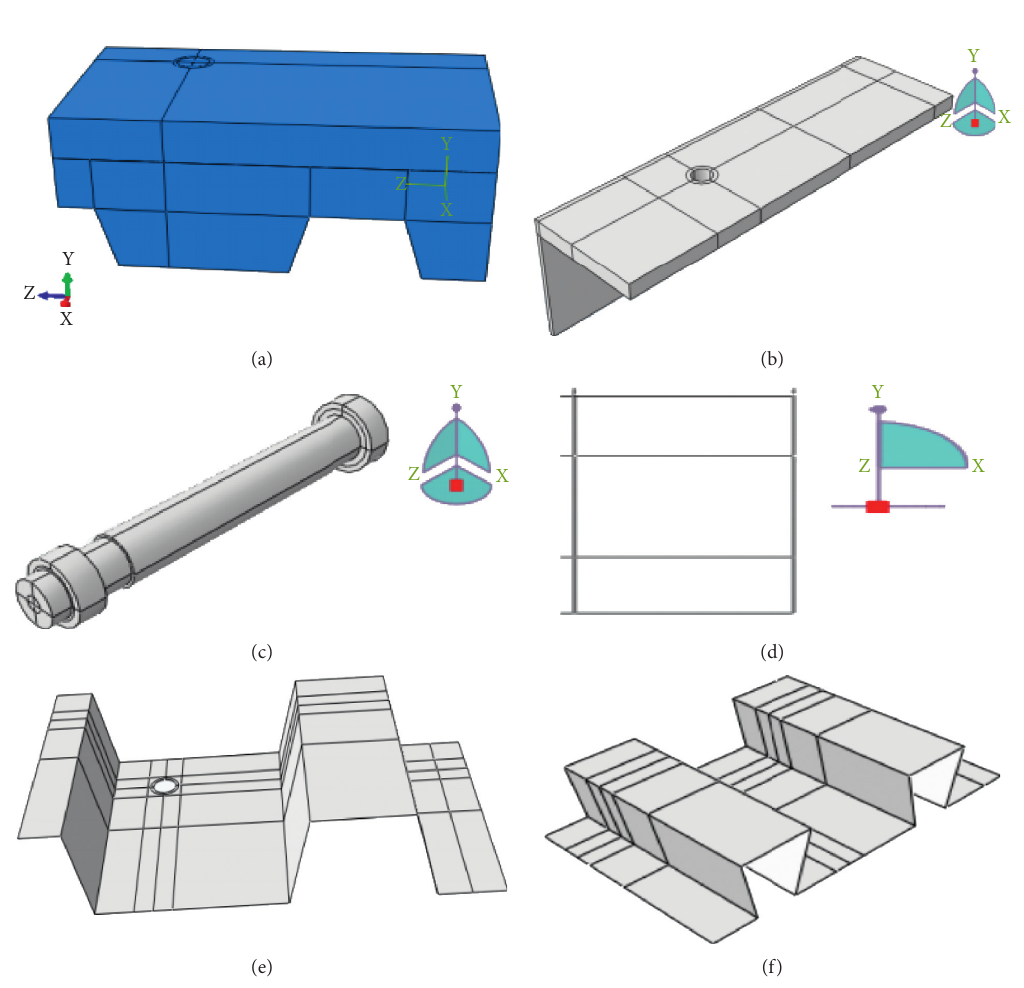
Figure 3: Parts modeled in FE software package.